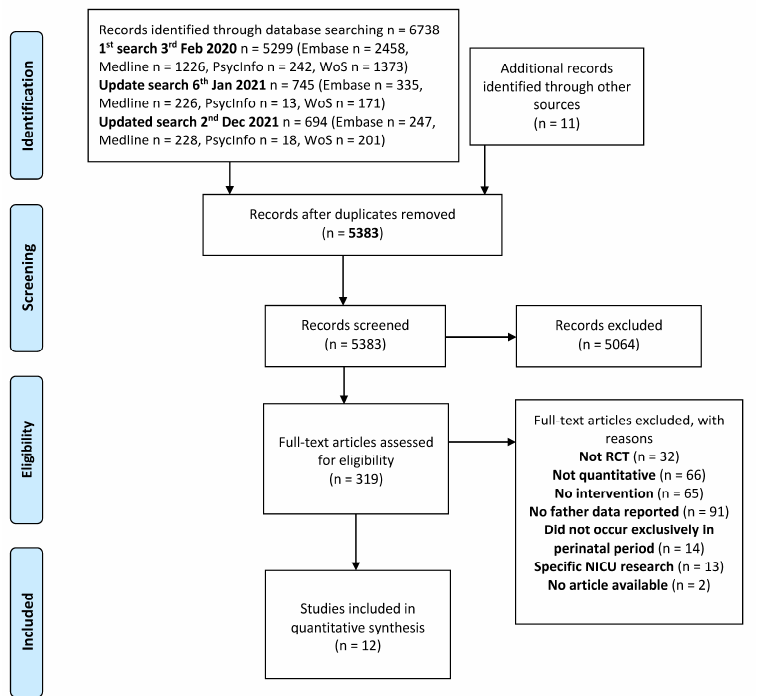
Figure 1. PRISMA (2009) Flow Diagram.